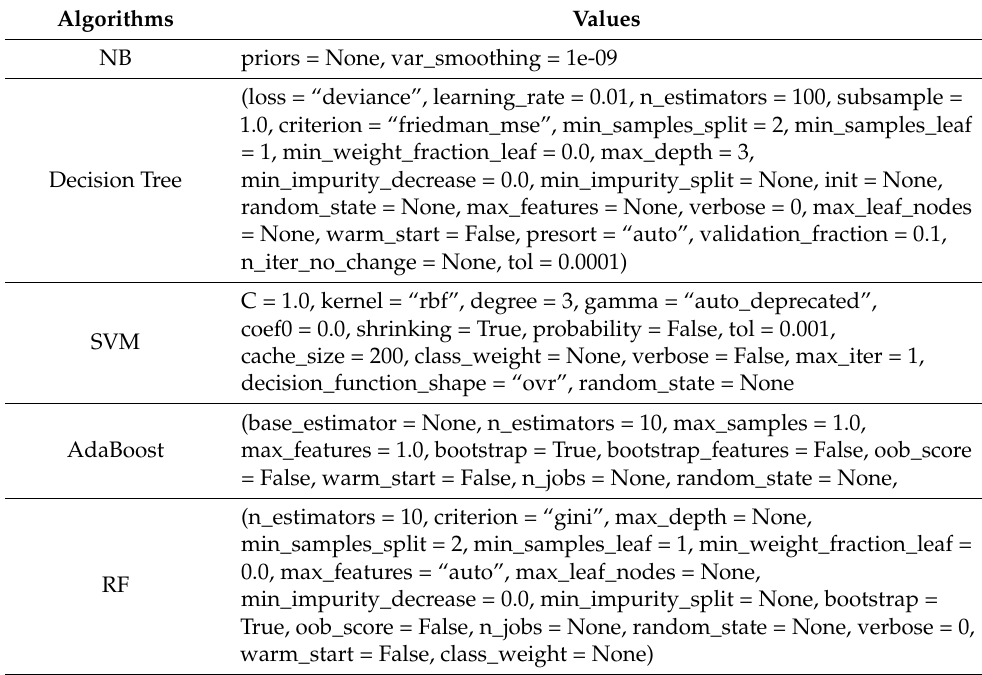
Table 12. Parameter settings for applied machine learning algorithms. Algorithms Values NB priors = None, var_smoothing = 1e-09